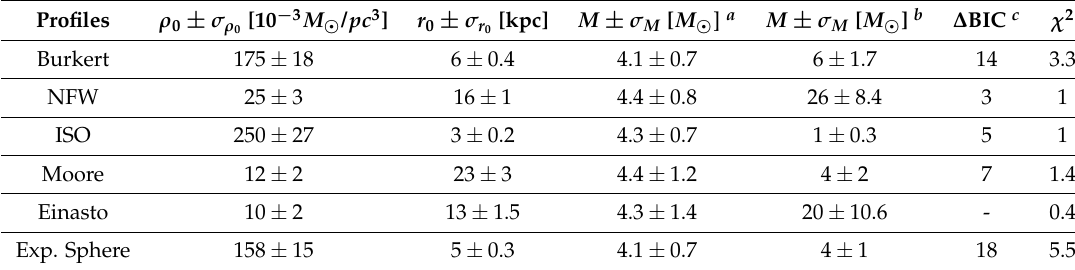
exponential sphere profile, though the difference between the values is not large. Table 1. Model parameters for the analyzed galaxy ESO0140040. We reported for each profile the density ρ 0 , r 0 and the masses expressed in terms of M (cid:12) . For every column we report the error bars. The last two columns report the BIC statistical outputs and the corresponding chi squares used for computing the BIC